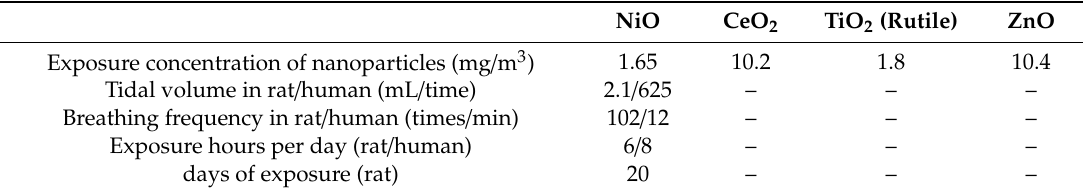
Table 1. Calculation conditions of multiple-path particle dosimetry model 2 (MPPD2) model and estimation of exposure time in humans. NiO CeO 2 TiO 2 (Rutile) ZnO Exposure concentration of nanoparticles (mg / m 3 ) Tidal volume in rat / human (mL /